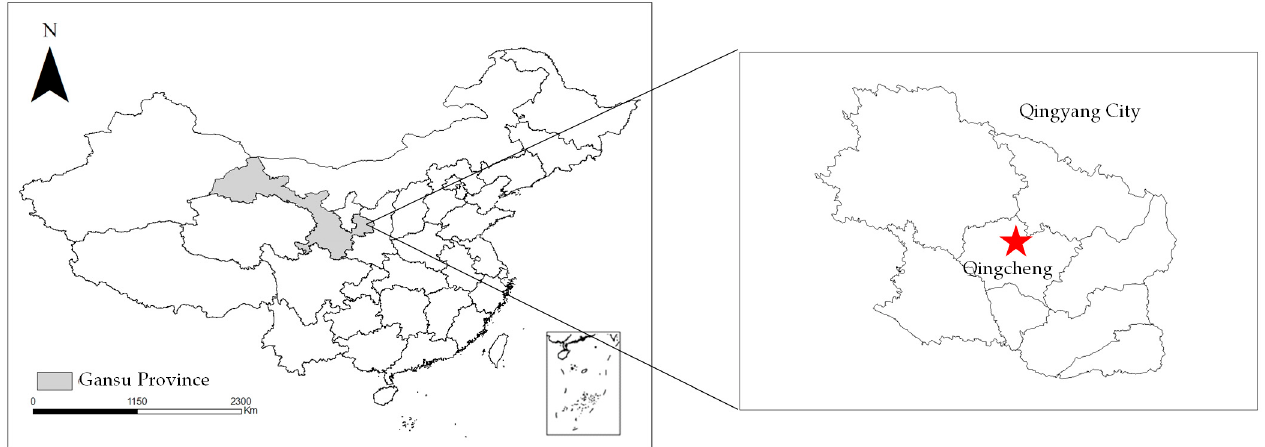
Figure 1. Locations of the apple production system in the study area of Gansu Province in China.